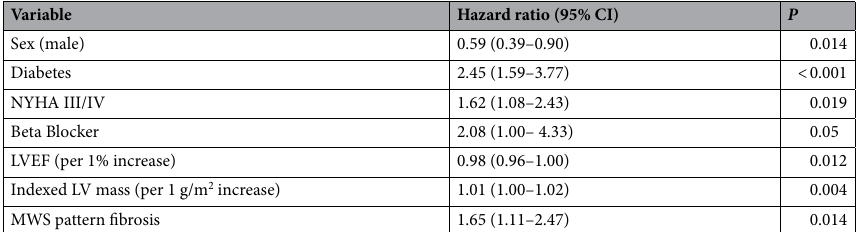
Table 1. Baseline clinical, electrocardiographic and laboratory characteristics for the study population, and for those patients with and without the primary outcome of heart failure admission. Results of univariable regression analysis is shown for associations with the primary outcome. BMI body mass index, BSA body surface area, NYHA New York heart association, ACE-I angiotensin converting enzyme inhibitor, ARB angiotensin II receptor antagonist, LVEF left ventricular ejection fraction, LVEDV left ventricular end diastolic volume, LVEDVi indexed left ventricular diastolic volume, LVESV left ventricular end systolic volume, LVESVi indexed left ventricular end systolic volume, RVEF right ventricular ejection fraction, RVEDV right ventricular end diastolic volume, RVEDVi indexed right ventricular end diastolic volume, RVESV right ventricular end systolic volume, RVESVi indexed right ventricular end systolic volume, LA vol left atrial volume, LGE late gadolinium enhancement. a NTproBNP was clinically performed in 208 subjects at time of CMR imaging. The "bold, asterisk" means that those hazard ratios are statistically significant with a p value of < 0.05.